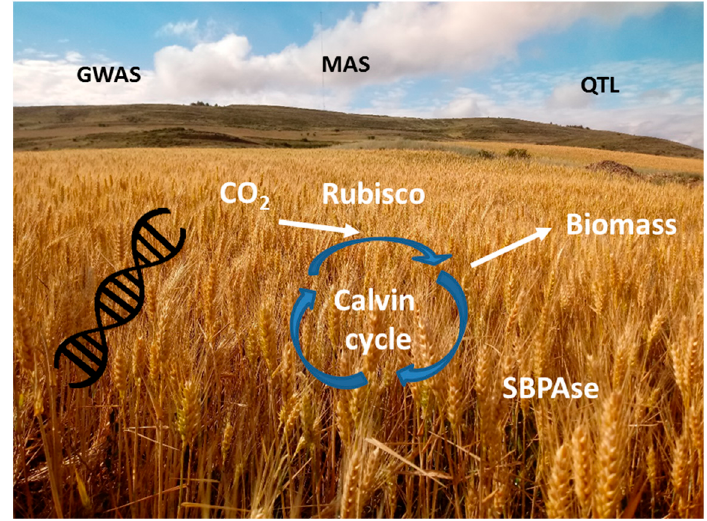
Figure 4. Photosynthesis-based multi-approach crop breeding. Plant photosynthesis, and therefore, growth is determined by multiple regulatory mechanisms. Previous studies have identified traits that may be targeted for modification to improve CO 2 assimilation rates and yield. Alongside traditional breeding programs, modern techniques enable the development of synthetic biology and genetic engineering to develop crops that are better adapted to stress.